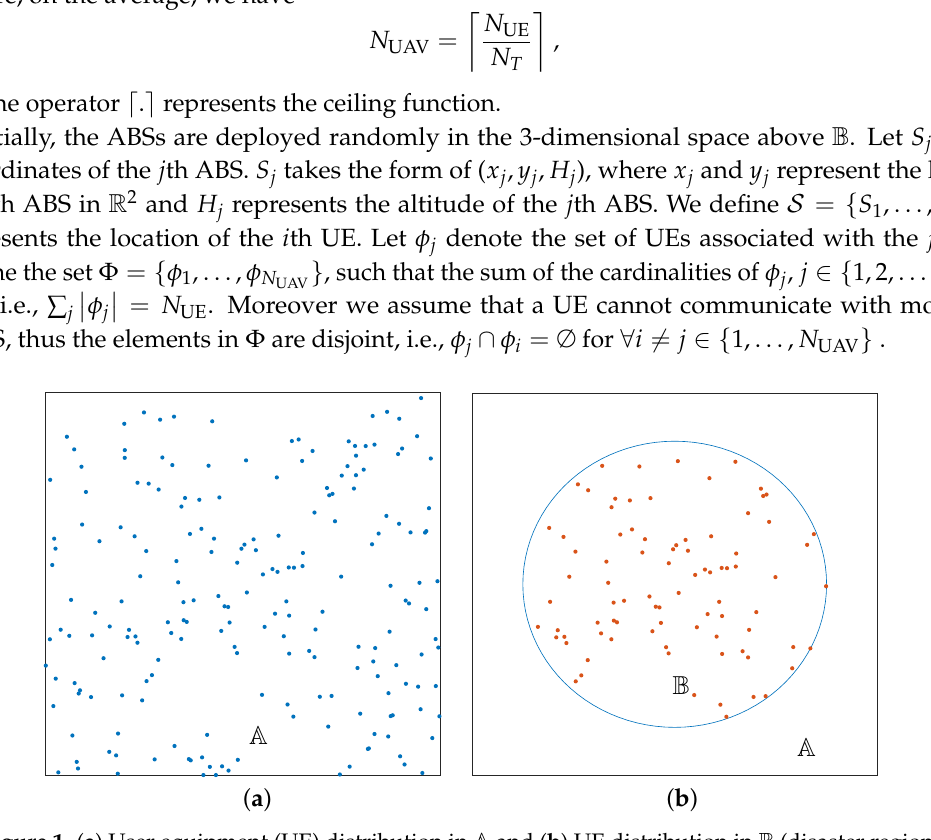
Figure 1. ( a ) User equipment (UE) distribution in A and ( b ) UE distribution in B (disaster